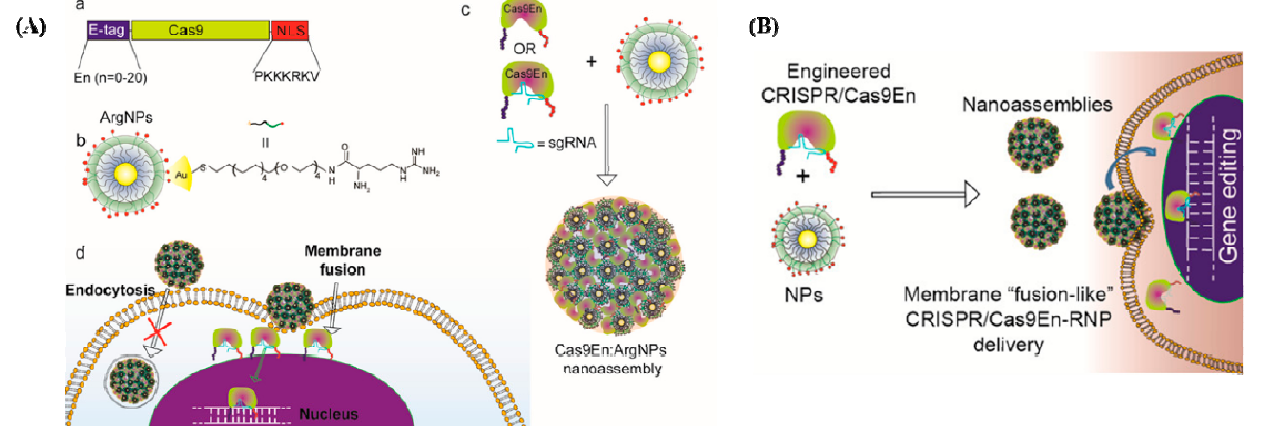
Figure 2. ( A ) Cas9/sgRNA delivery using AuNPs and gene editing. ( a ) Cas9 protein engineered with ArgNPs for intracellular delivery of Cas9-protein/RNP through membrane fusion. Illustration of Cas9 transporting an E-tag at the N-terminus and a nuclear localization signal at the C-terminus (NLS). ( b ) Chemical structure of ArgNPs. ( c ) Nano assembly of Cas9En-RNP and ArgNPs. ( d ) A membrane fusion method for delivering Cas9En (reprinted with permission from [35]). ( B ) Conjugation of Cas9 nuclease and carrier NPs makes CRISPR component packing and transport more efficient. Cas9En self-assembled into massive nano assemblies with arginine-functionalized-AuNPs (reprinted with permission from [35]).